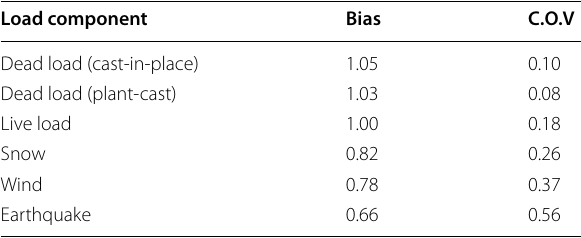
Table 5 Statistical parameters for load combinations (Szerszen & Nowak, 2003)